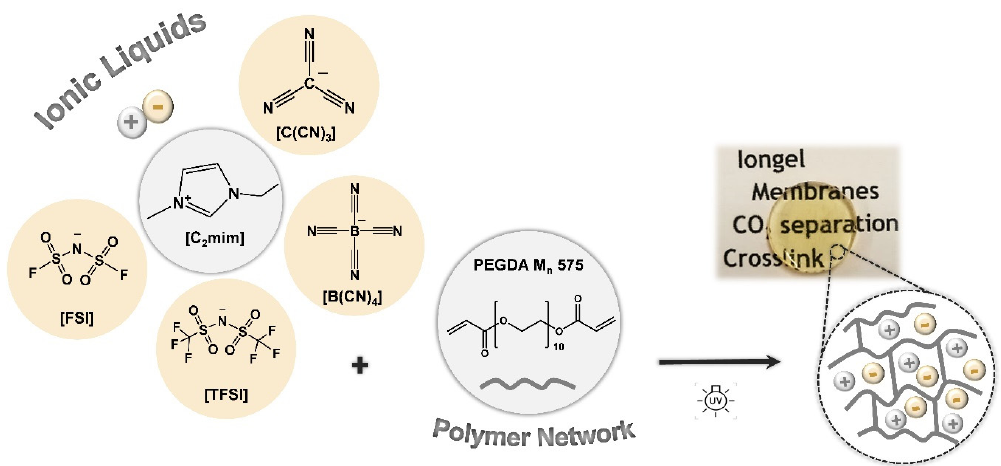
Figure 1. Chemical structures of the ionic liquids (ILs) and polymer network (PEGDA) used in this